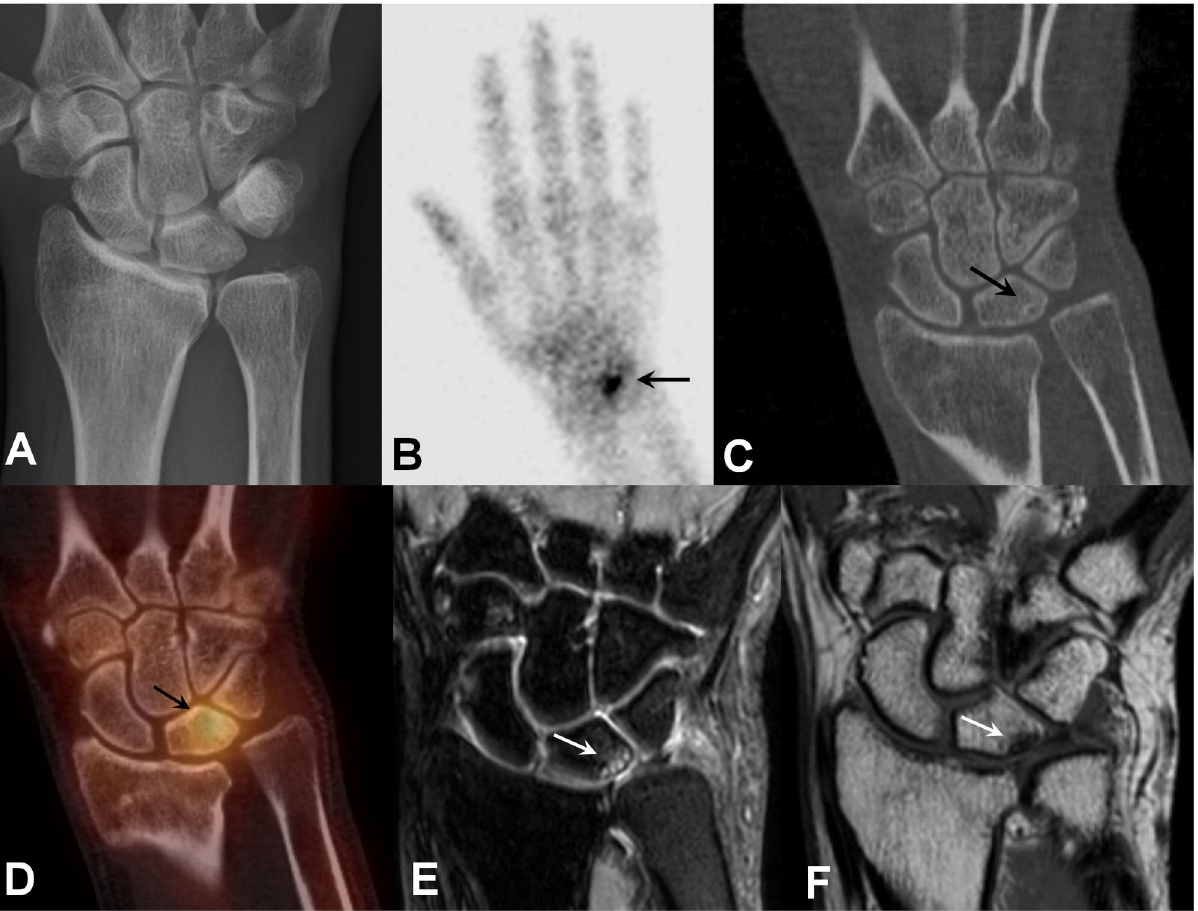
Figure 1. 50-year-old female with ulnocarpal impaction syndrome. Relative overlength of the distal articular surface of the ulna on plain radiograph with localized geographic cystic-sclerotic changes in the medial proximal pole of the lunate and overprojection of TFCC calcification (a), focally increased radiotracer uptake in the carpal region on bone scan (b, arrow), subcortical cyst with rim sclerosis at the proximal ulnar pol of the lunate bone on CT (c, arrow), subcortical cyst displaying tracer accumulation on SPECT/CT fusion image (d, arrow), several subchondral cysts with adjacent alterations of bone marrow signal in the proximal ulnar pol of the lunate bone in PDw SPIR (e, arrow) and T1w image (f, arrow) on